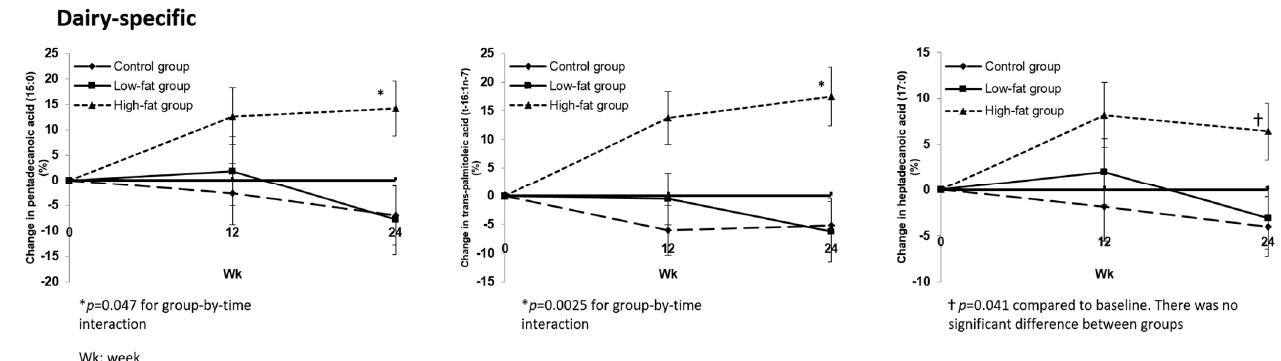
Figure 1. Percent change in dairy specific plasma fatty acids among study groups. Data are least-square mean difference ± SEM. Intent-to-treat population: control group (n = 38); low-fat group ( n = 36); high-fat group ( n = 37).